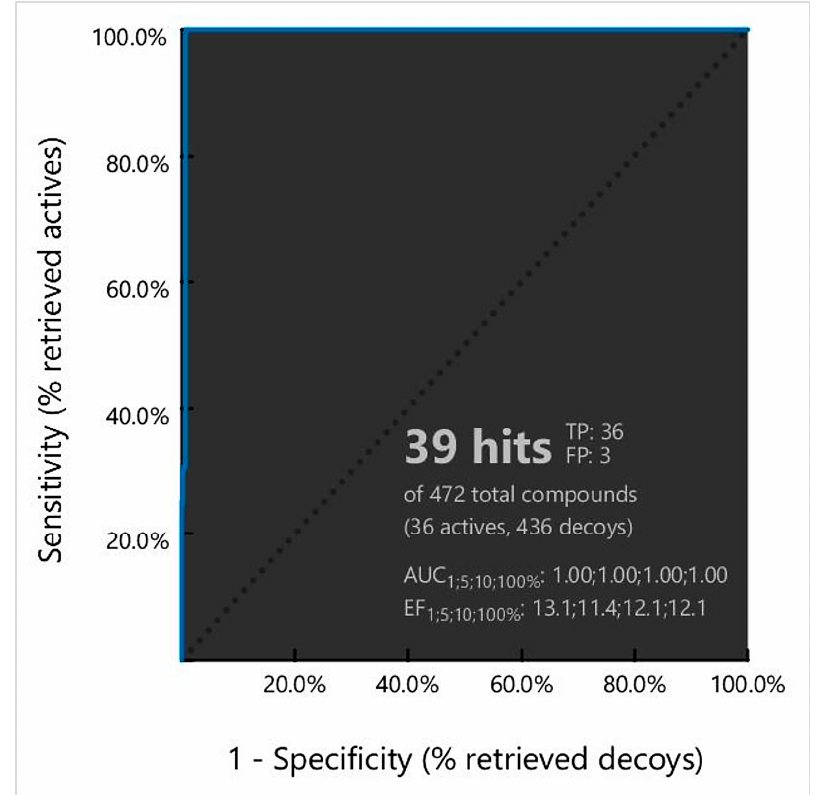
Figure 2. Representing a receiver operating characteristic (ROC) curve obtained during the pharmacophore model validation process. The total number of active and decoy sets was determined using the ChEMBL and DUD-E decoy databases, respectively.